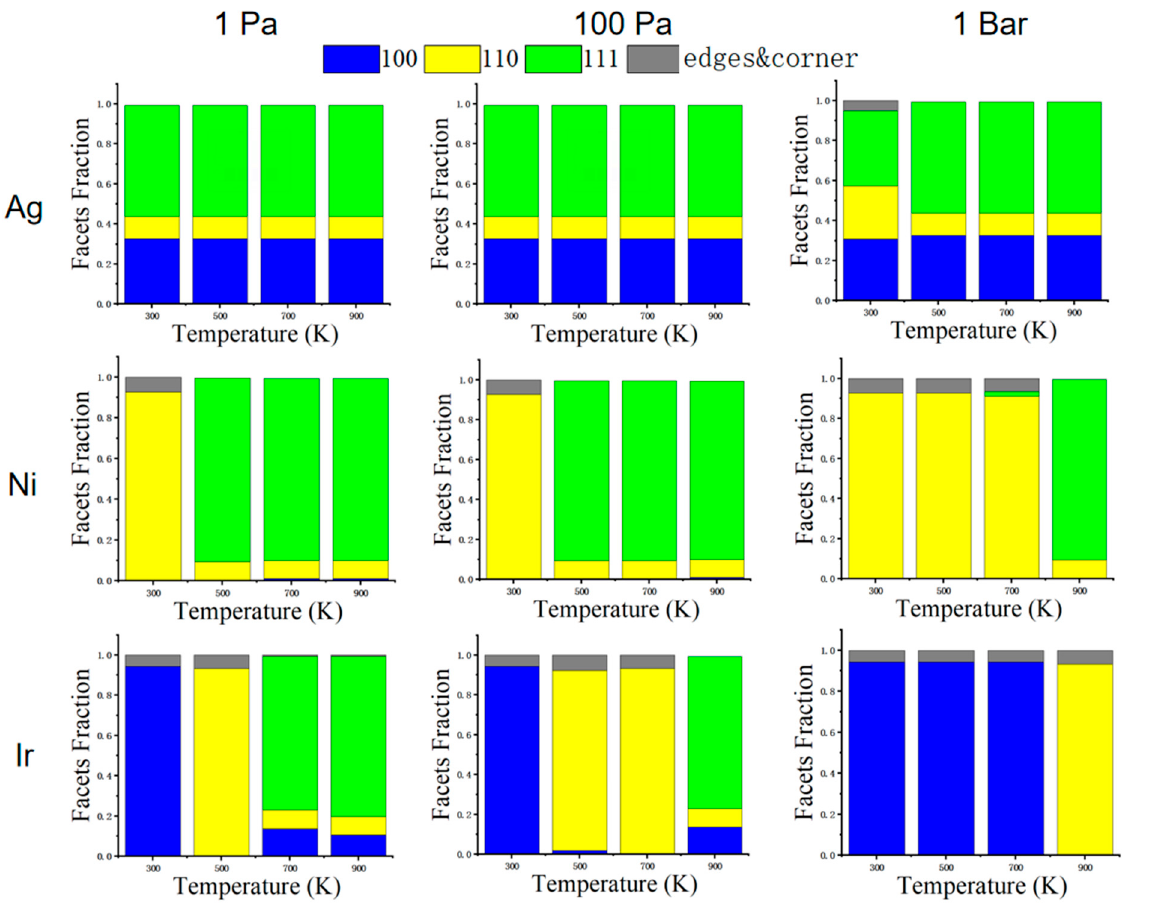
Figure 7. The fraction of (100), (110), and (111) facets of corresponding structures under three pressures (1 Pa, 100 Pa, and 1 bar). Coordination numbers less than seven are defined as edge and corner atoms.